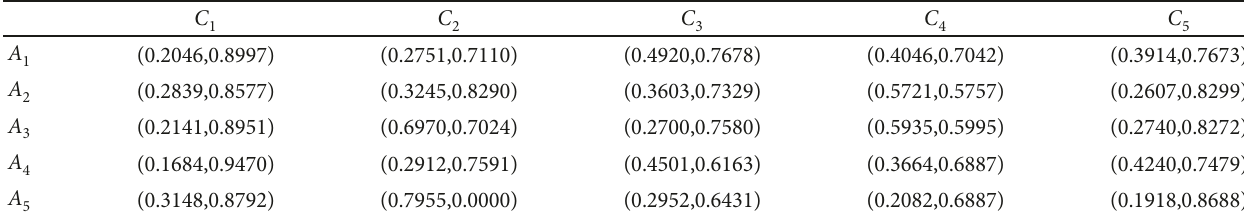
Table 8: Pythagorean fuzzy weighted decision matrix D ″ .